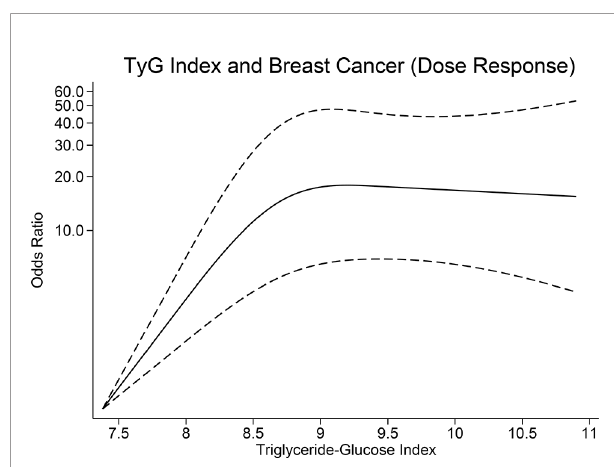
FIGURE 1 | Dose-response relationship between triglyceride-glucose index and breast cancer.